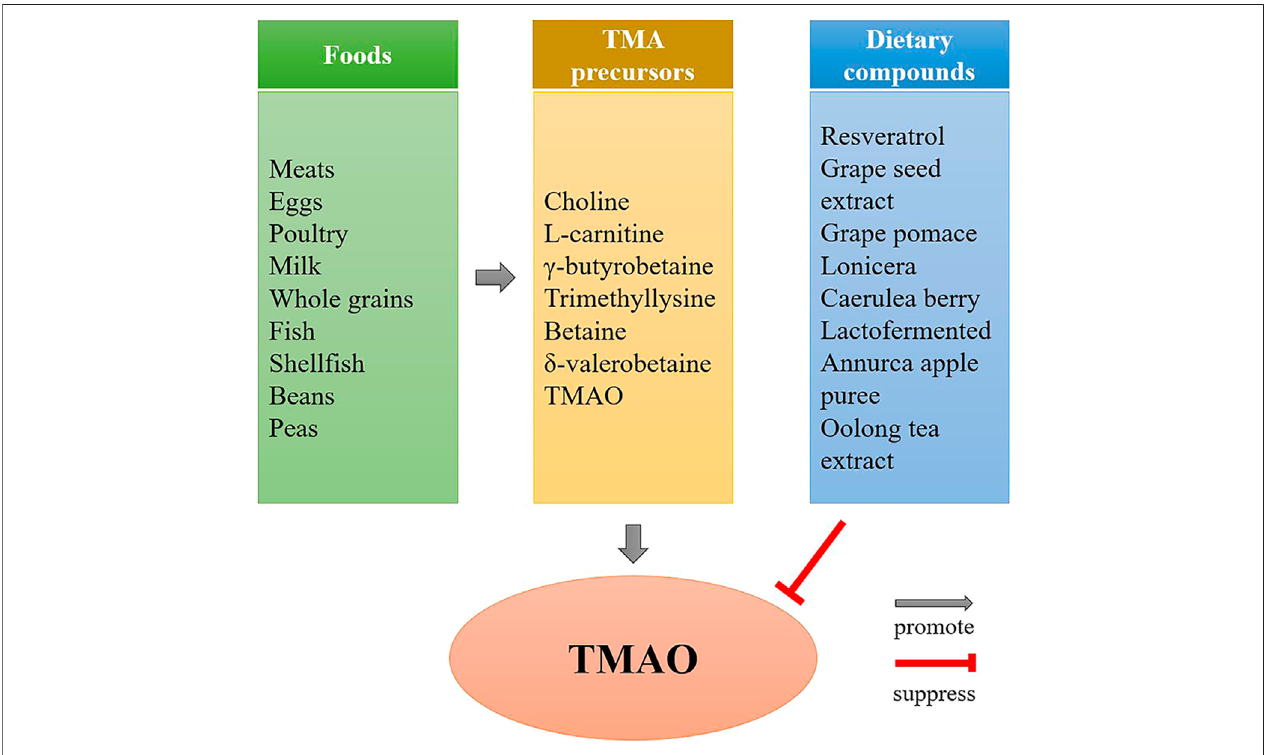
FIGURE 2 | The effect of diet on TMAO formation. Diets rich in TMA precursors, such as red meat, eggs, fi sh, etc., are the main source of TMAO, while the TMAO concentrations can be reduced by some dietary compounds, such as resveratrol, grape seed extract, etc.